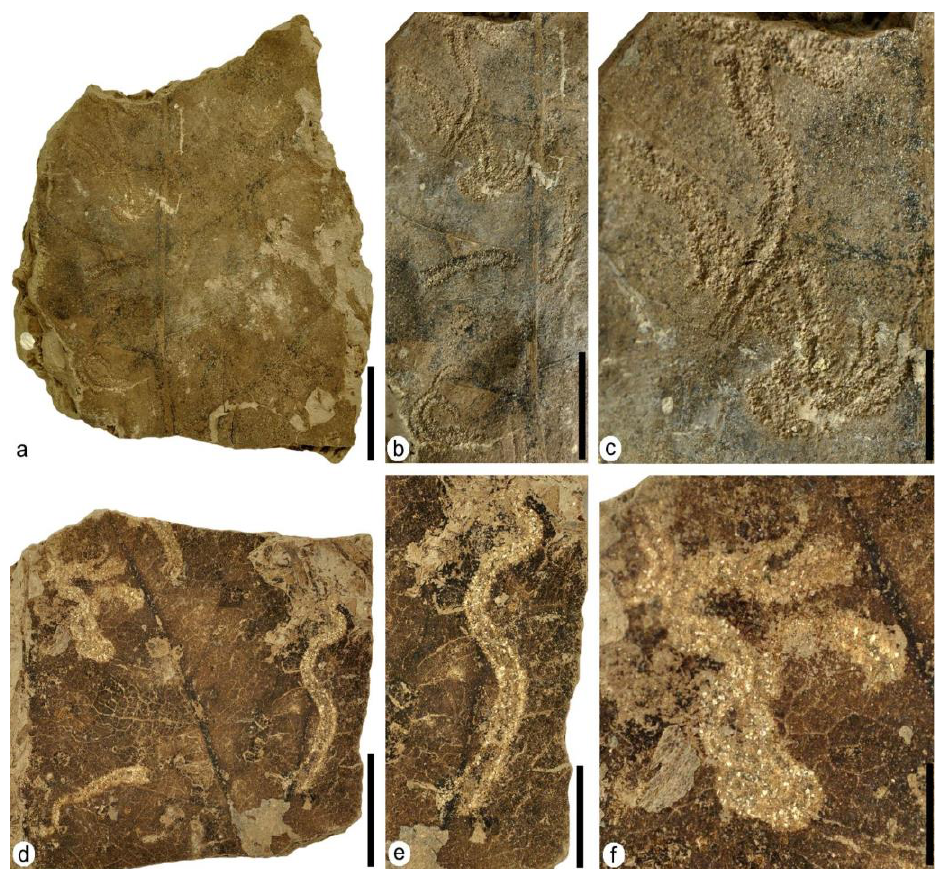
Figure 8. Plant–insect interactions—mining—on leaves of the terrestrial Angiosperm Type 1 with mining DT43 bearing serpentiform mines. ( a ) MAP-8369, fragment of a big leaf with several mines. ( b ) Detail of the left part of the leaf showing most of the mines from photo ( a ). ( c ) Detail of upper left part from photo ( b ) with two crossing mines bearing densely packed solid frass along the margins . ( d ) MAP-8370, another fragment of a big leaf with well-defined mines. ( e ) Detail of the right part from photo ( d ) showing a serpentine mine. ( f ) Detail of the upper left part from photo ( d ) showing a serpentine-convolute mine with both the margins and center covered by tiny coprolites. Scale bars: ( a ) = 2 cm; ( b , d ) = 1 cm; ( c , e , f ) = 5